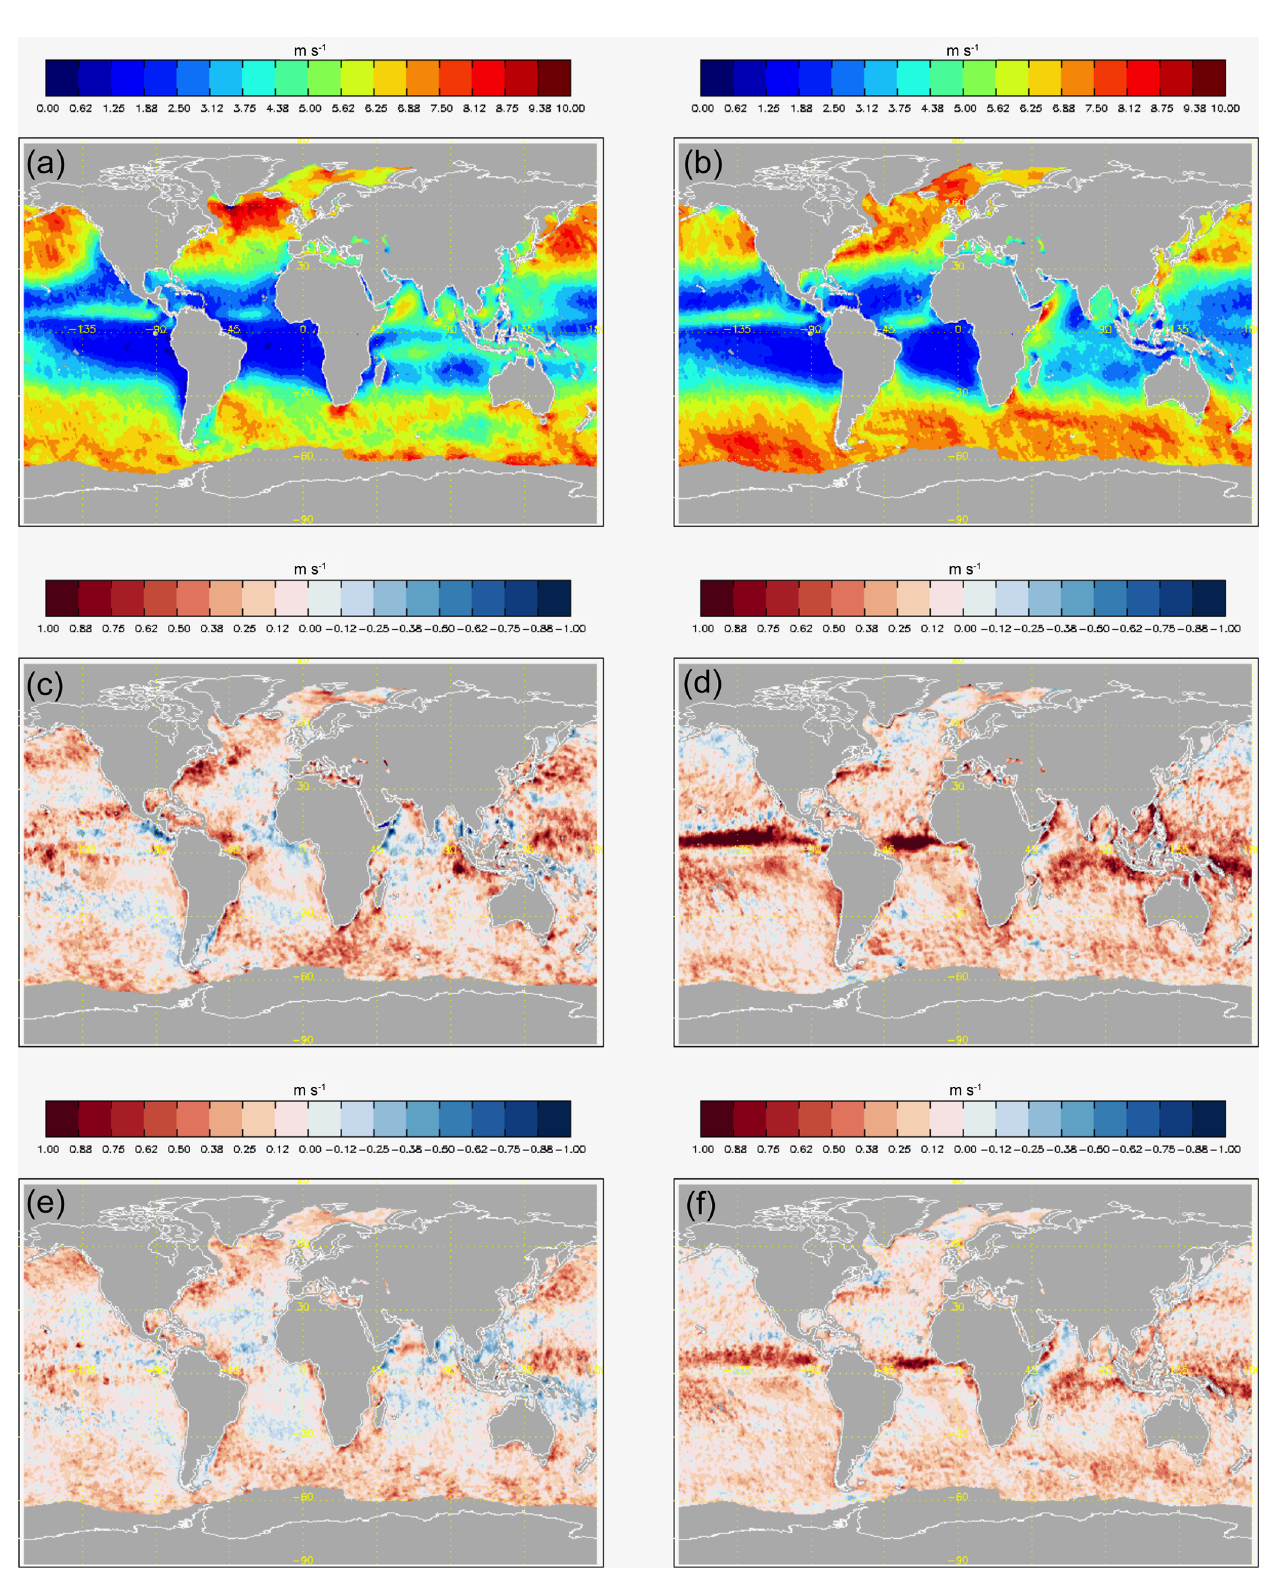
Figure 6. Global maps of annual mean zonal (a) and meridional (b) transient wind from ASCAT and differences from ERA-Interim (c, d) and ERA5 (e, f) first-guess winds over